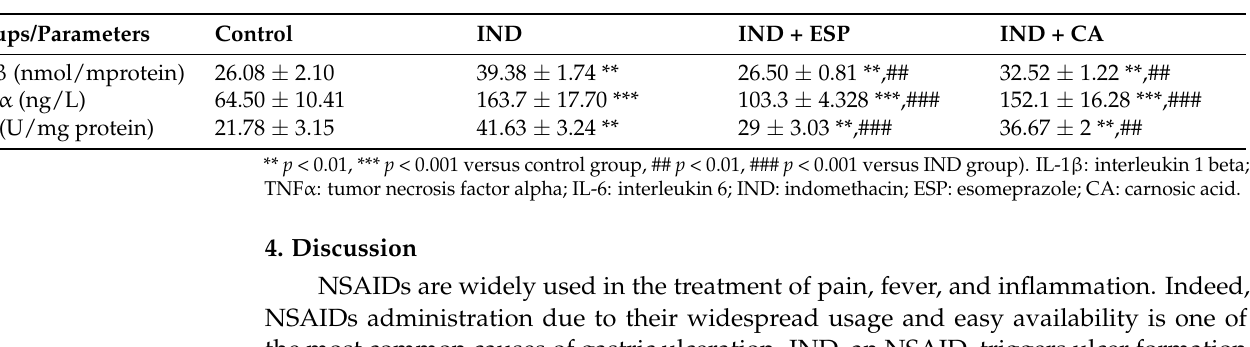
Table 5. Effects of CA on inflammatory markers in gastric tissues of ulcerated rats. Data are expressed as ± SEM, n =